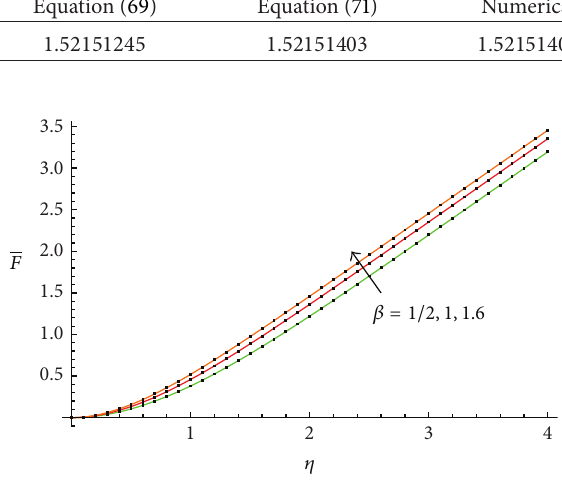
Table 27: Comparison between the values of 𝐹